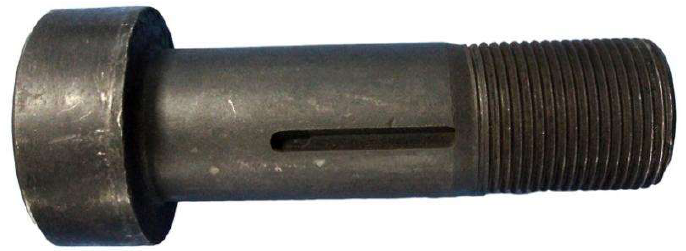
Figure 4. The M60 high-strength bolt used in this work.